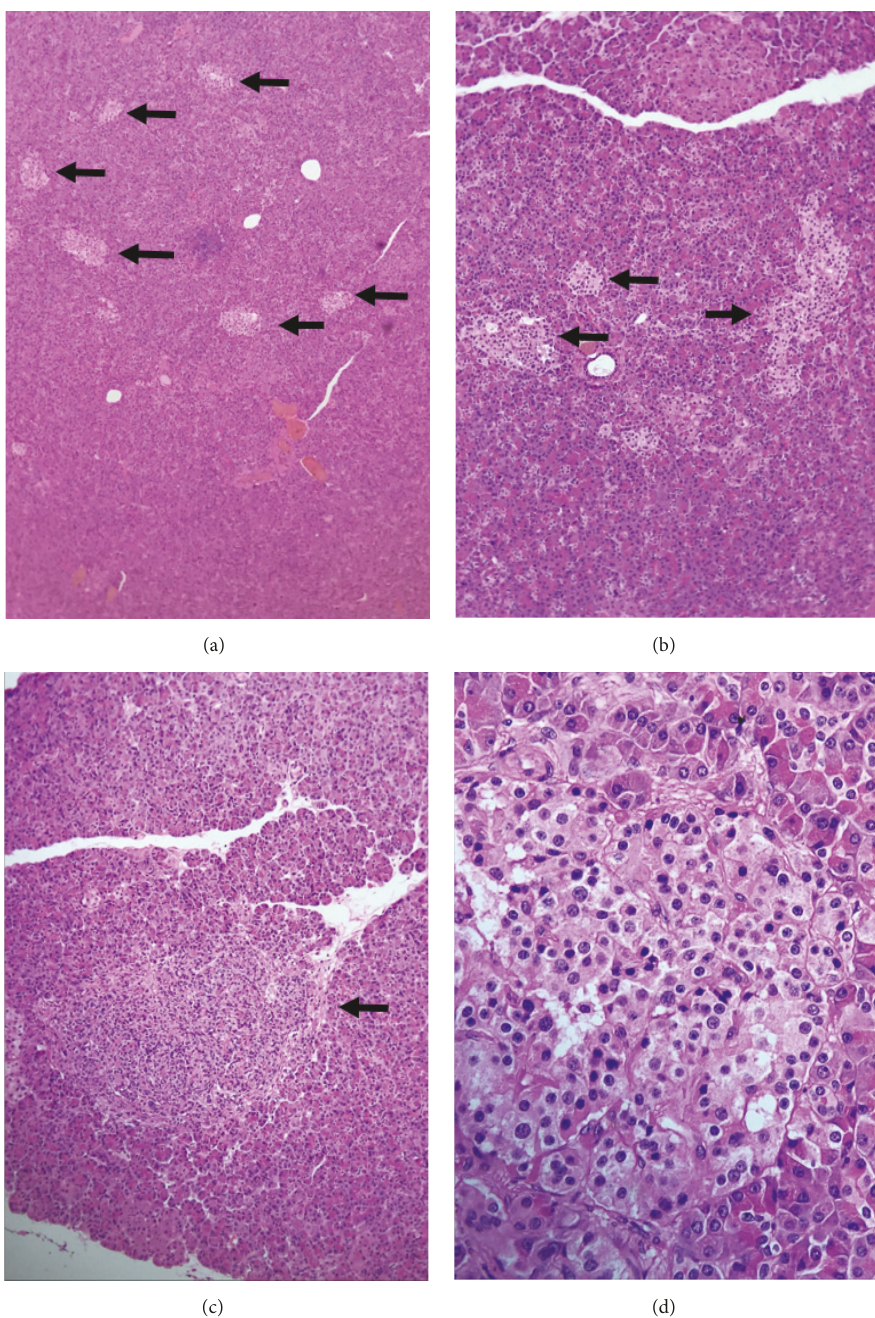
Figure 2: Hematoxylin and eosin stain of cell-block preparations from biopsy specimen. (a) Several clusters of 𝛽 pancreatic cells are shown (arrows) (10x). (b) The typical cluster distribution near blood vessels is depicted (10x). (c) Pancreatic islets vary in size; very large islets are shown (arrow) (10x). (d) Hematoxylin and eosin stain shows cells with atypical morphology characterized by prominent nuclei and abundant granulated eosinophilic cytoplasm